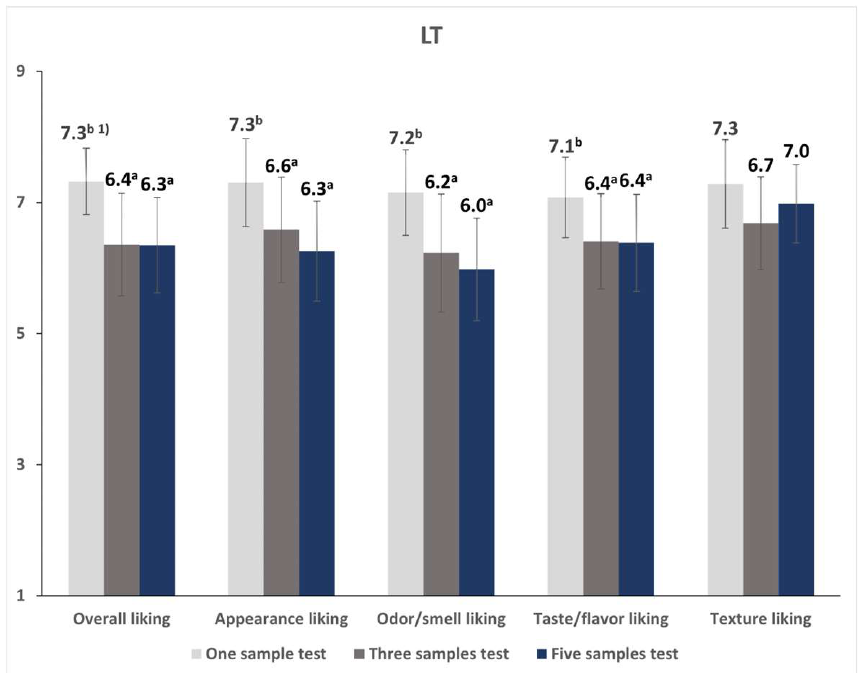
Figure 6. Mean liking scores of the vegan ramen test target sample according to the number of evaluation samples in the lab condition test. 1) Within a sensory attribute, different letters indicate significant differences between the mean values of a different number of evaluation samples ( p < 0.05).